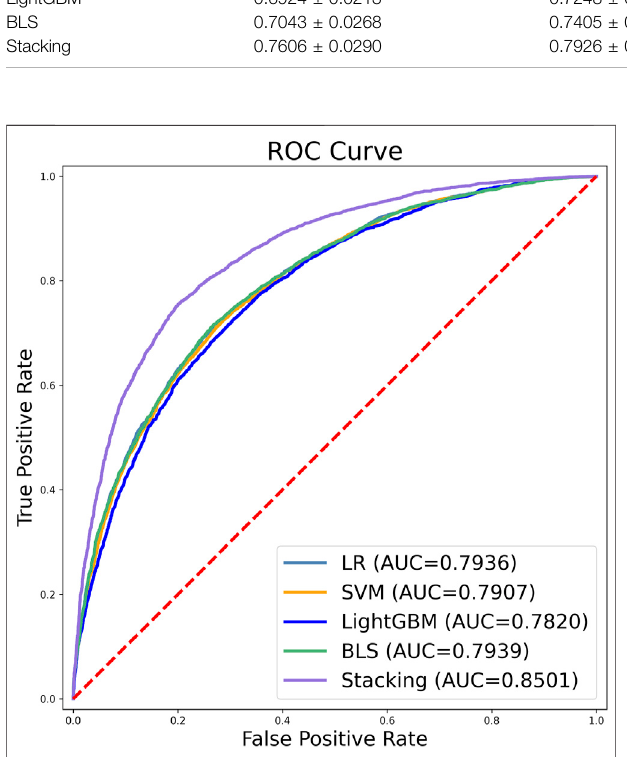
FIGURE 8 | Receiver operating characteristics (ROC) curves for the fi ve classi fi ers according to 10-fold cross-validation. The value of AUC represents the area under the ROC curve.